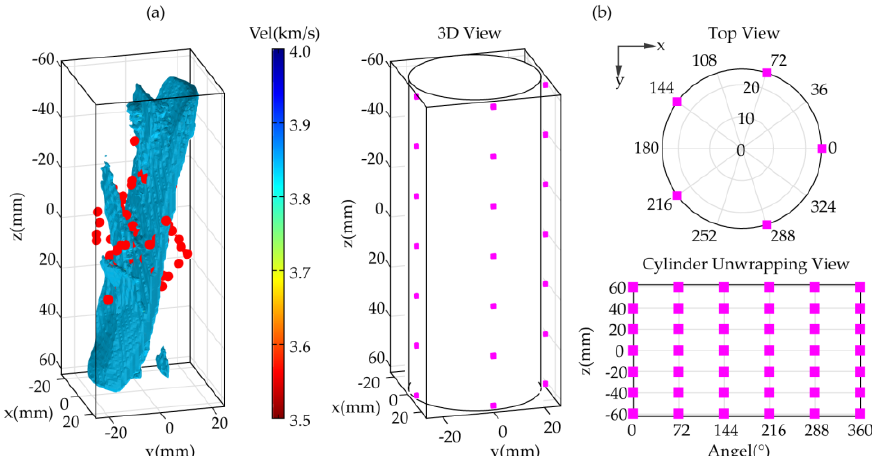
Figure 8. ( a ) 95 sources (red dot) set in the rock column; ( b ) 35 receivers (magenta square) placed around it under dense ray-coverage case and the observation geometry is shown with three views.